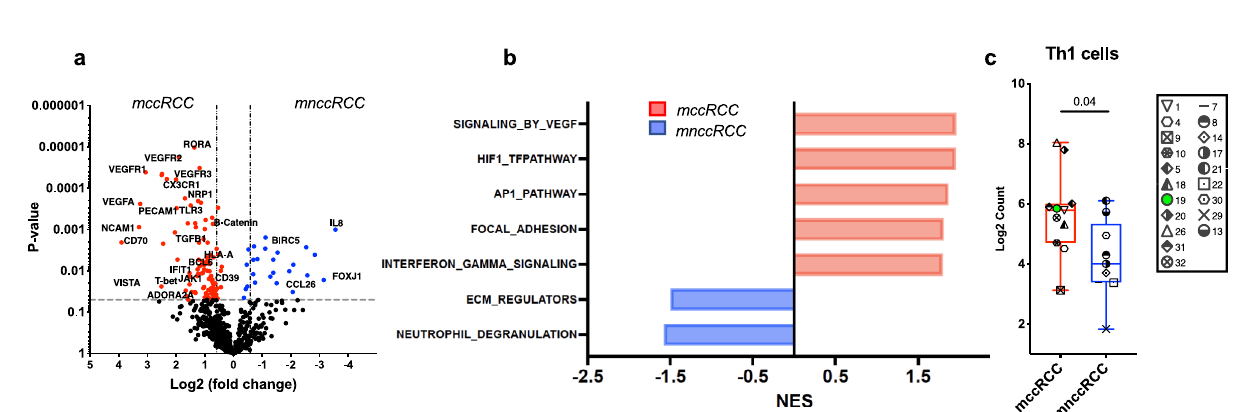
Fig. 3 Patients with mccRCC have a favorable tumor immune microenvironment. a – c Nanostring analysis comparing pre-treatment tissue samples of 20 mRCC patients with clear cell (mccRCC) versus non-clear cell (mnccRCC) histology (mccRCC, n = 11; mnccRCC, n = 9). a Volcano plot illustrating differentially expressed genes (DEGs). Colored points above the cutoff in the plot show DEGs with p < 0.05 and fold change ≥ 1.5 that are either upregulated (red) or downregulated (blue) in mccRCC compared to mnccRCC samples. Two-sided P values are from Welch ’ s t test. b Bar plots showing differentially activated pathways in tumor tissue samples from patients with mccRCC versus mnccRCC. Upregulated pathways in mccRCC are indicated by red bars while downregulated pathways are indicated by blue bars. P values (FDR-adjusted <0.2) are from GSEA algorithm and c Boxplot showing in fi ltration with Th1 cells. The ends of the box are the upper and lower quartiles (75th and 25th percentiles), the median is the horizontal line inside the box, and whisker lines extend to outliers (minimum and maximum). P value was calculated using the two-tailed unpaired Mann – Whitney test. Each patient is identi fi ed by a unique symbol as shown in the inset on the right. Red box whiskers show mccRCC and blue box whiskers show mnccRCC cohort of patients. Patients with ongoing responses are shown in green. P < 0.05 denotes signi fi cant differences. mccRCC metastatic clear cell renal cell carcinoma, mnccRCC metastatic non-clear cell renal cell carcinoma, NES normalized enrichment score, Th1 T helper cells type 1. Source data are provided as Source Data fi